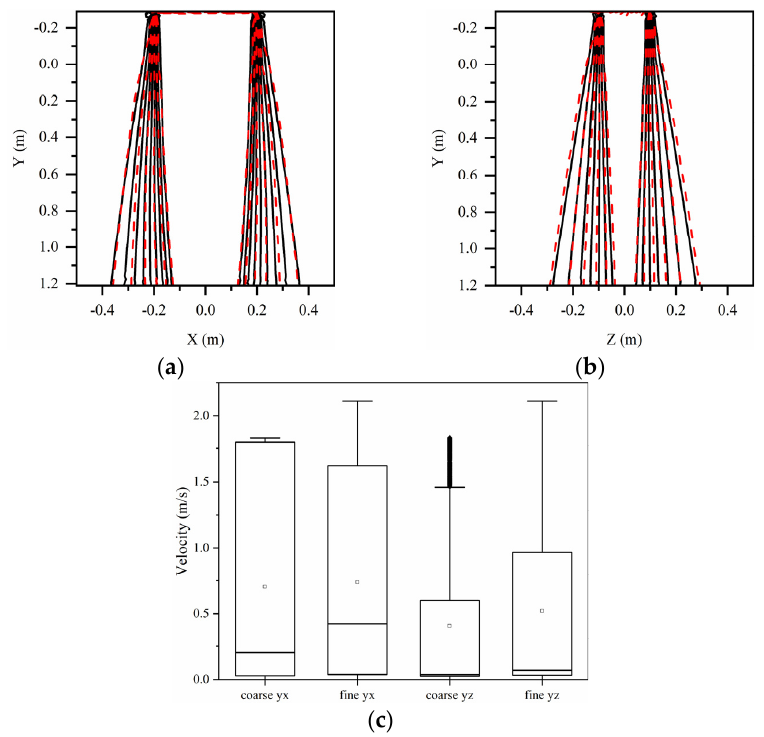
Figure 6. Velocity mapping for y-x ( a ) and y-z ( b ) planes and ( c ) boxplot of velocities. Red dashed lines represent the detailed diffuser geometry values, and black is the simplified N-point diffuser geometry. Figure 6a, b shows that two sets of contours are overlapping each other. The difference between the two types of discretization can be showcased in a boxplot (Figure 6c). One can see that the median values are close to each other at both the y-x and y-z planes. On the y-x plane, a smaller deviation can be seen, which can be owing to the fins of the diffuser while the absence of the fins leads to smaller deviation on the y-z plane for the coarser/simplified case. The difference between the coarse and fine mesh due to the low magnitude of velocity is acceptable. The error be- tween the two mesh is not calculated since the different discretization density does not allow for calculating the exact error. In further simulations, only the simplified versions of the diffusers were used. A classic mesh dependency study was not made, however, mesh refinement at certain zones decreased the difference between the modeled and measured velocities. 3. Developed Air Ventilation System Element (Air-Jet Control Box) Most office spaces are equipped with mixed ventilation, which leads to higher con- tamination concentration in the occupied zone. To lower the risk of transmission of vi- ruses, the induction rate of the diffusers needs to be decreased which leads to more evenly distributed primary air in the occupied zone. There are two effective ways to protect the occupants from developing contamination in the occupied zone. One is to keep a physical distance between the seated people, and the second one is to decrease the air mixing in the occupied zone. Acknowledging this, investigations have been conducted to find which air supply equipment has a low induction rate. During the study, it was concluded that a more advantageous flow pattern can be achieved with the vent grilles as can be seen in Table 2 based on the manufacturer’s design software (Schako Luft). Table 2. Induction rates of swirl diffuser compared to a grill.